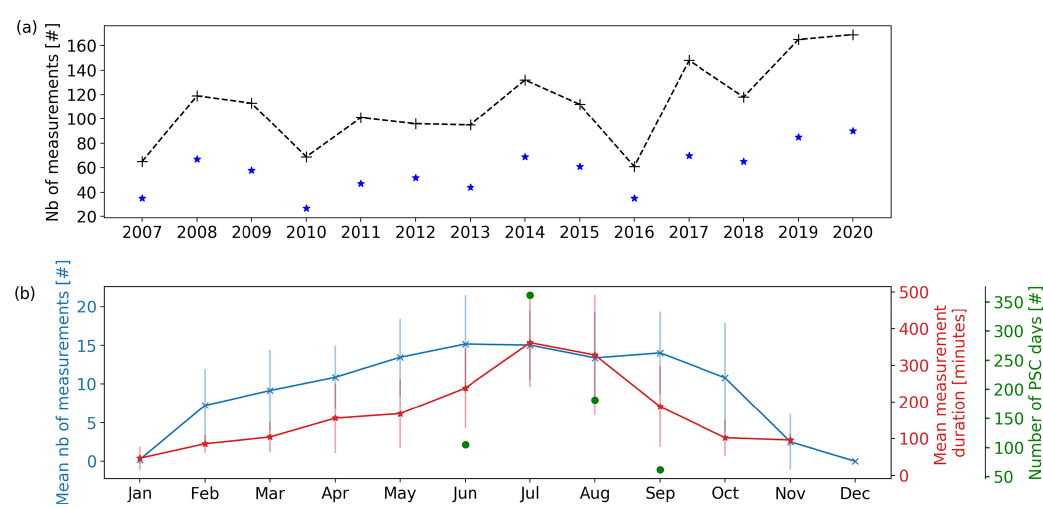
Figure 1. Operation statistics of DDU lidar. (a) Number of measurement days per year (black line) and per winter (blue stars) from 2007 to 2020 and (b) mean number (blue line) and duration (red line) of measurement sessions per month, in minutes, from 2007 to 2020. Total number of PSC days at DDU in June, July, August and September between 2007 and 2020 (green